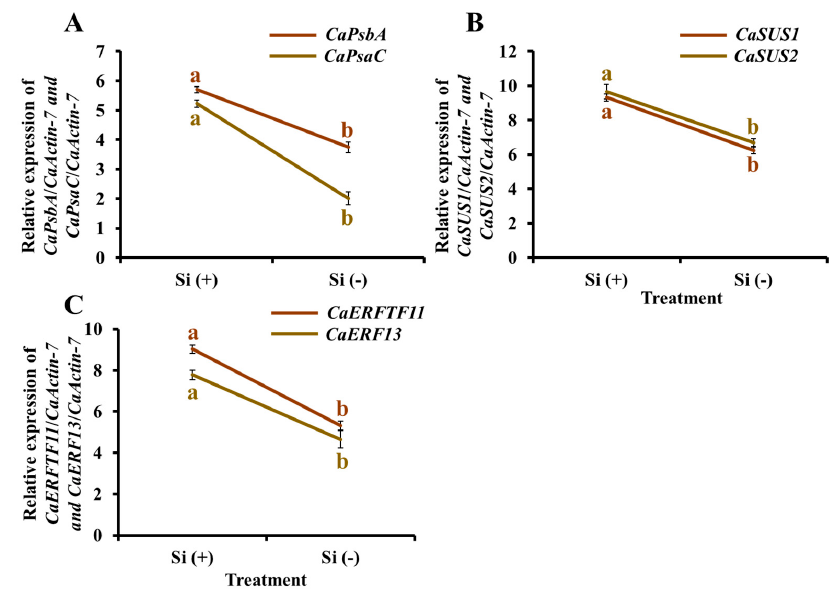
Figure 10. Effect of 30 days of silicon application on gene expression levels in the coffee plants grown in plant growth chambers. Photosynthesis-related genes ( A ): CaPsbA and CaPsaC . Sucrose synthesis-related genes ( B ): CaSUS1 and CaSUS2 . Defense genes ( C ): CaERFTF11 and CaERF13 . Si (+) and Si ( − ) refer to 75 and 0 mg·L − 1 , respectively. Vertical bars indicate the means ± standard error ( n = 6). Different lowercase letters indicate the significant separation within treatments by the Duncan’s multiple range test at p ≤ 0.05. 3. Discussion In natural conditions, plants suffer from various types of stresses caused by living organisms such as bacteria, viruses, fungi, parasites, and significant and non-significant insects. On invasion by pathogens and herbivorous pests, plants make use of pre-existing physical, chemical, and mechanical barriers to protect themselves. The defense functions of plants are also activated upon attack by pests; plant protections act as a unit to decrease in negative responses to biotic stress [23]. Numerous experiments show the impact of Si on plant tolerance to environmental stresses [24–29]. The amount of research articles cur- rently published on the mitigation of plant stress by Si demonstrate the level of interest in this area [24,30–33]. However, the underlying Si-mediated mode of action to enhance plant resistance to disease and insect pests is unclear. Investigations attribute its influence on the reduction of disease and insect pest attacks via the development of physical barriers by Si deposition and chemical defense through enzyme production. Moreover, research- ers have uncovered Si-mediated biochemical and molecular mechanisms in plants that enhance disease tolerance and improve the plant’s ability to survive against insect pest attacks (Figure 2) [22]. 3.1. Si Mitigates Biotic Stress in Plants: Physical and Mechanical Level Supplementing plants with Si has been shown to enhance plant tolerance to mam- malian, arthropod, and molluscan herbivores, fungal and bacterial pathogens, as well as viruses and nematodes [27,31,34–37]. Si is translocated from the soil solution as mono- silicic acid into plants. Monosilicic acid polymerizes to form phytoliths, which are accu- mulated within the plant in an irreversible manner [38]. The physical defense induced by Si deposition in plant parts in the form of phytoliths (largely composed of SiO 2 ) was one of the first theories proposed for studying stress tolerance to pests [39,40]. The deposition